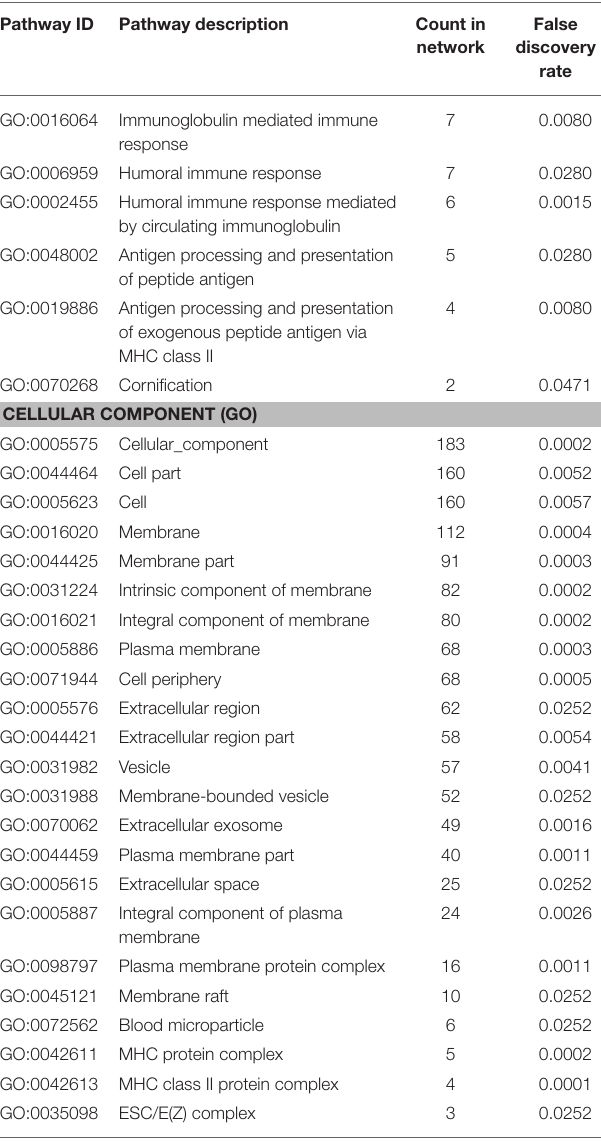
TABLE 5 | Continued Pathway ID Pathway description Count in